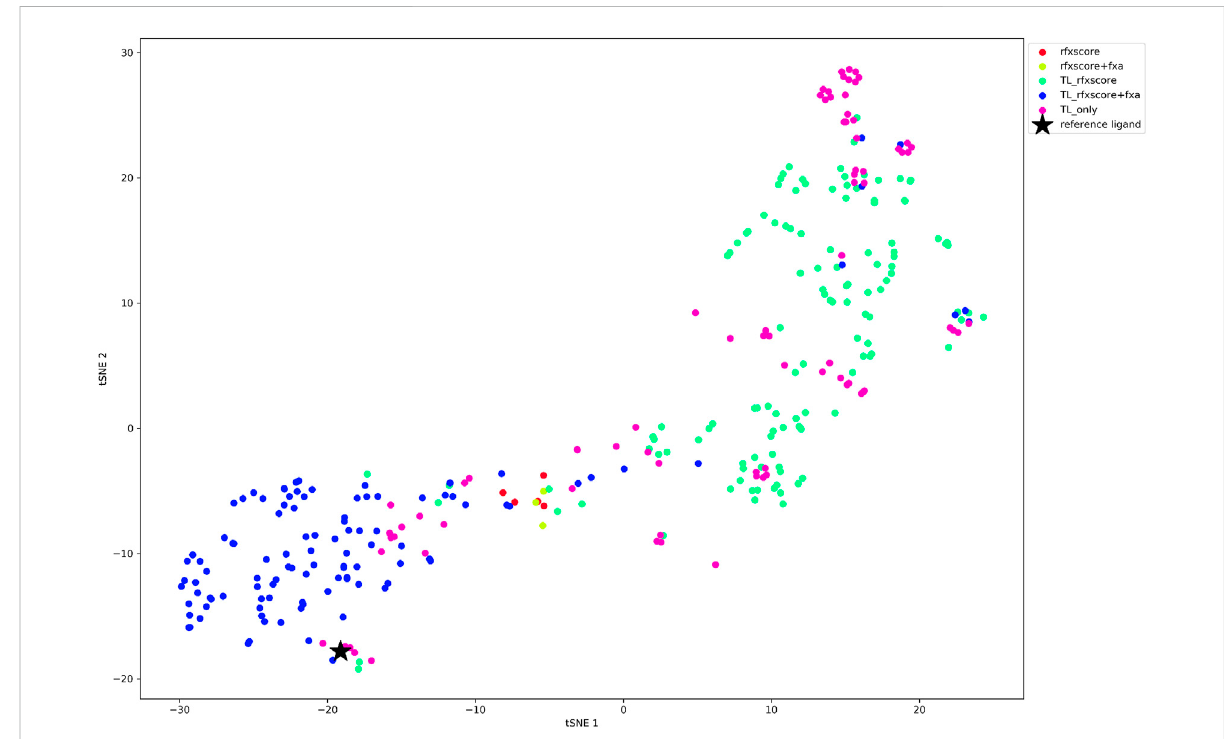
FIGURE 12 tSNE plot of the fi nal molecules for each REINVENT run, color-coded according to the scoring